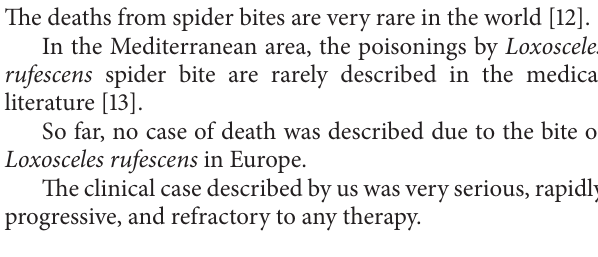
Figure 4: Deterioration and extension of necrotic tissue